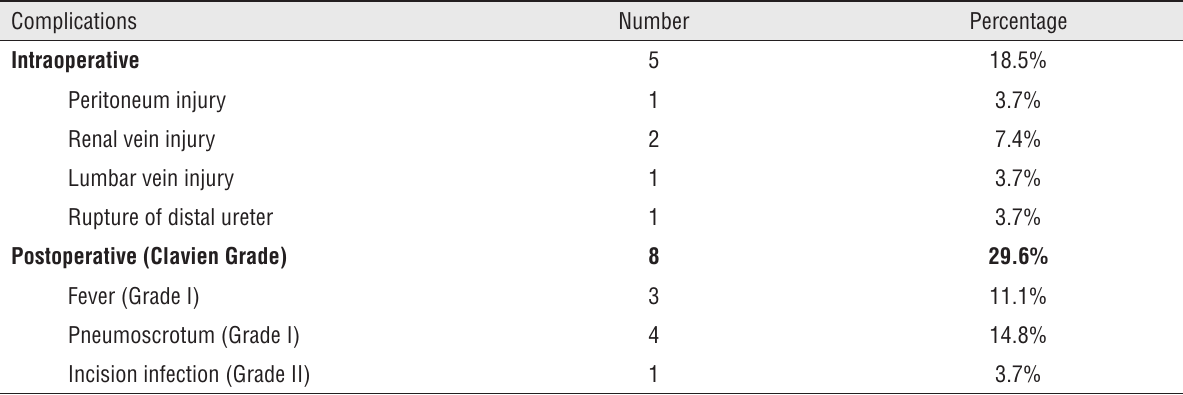
Table 1 - Details of perioperative